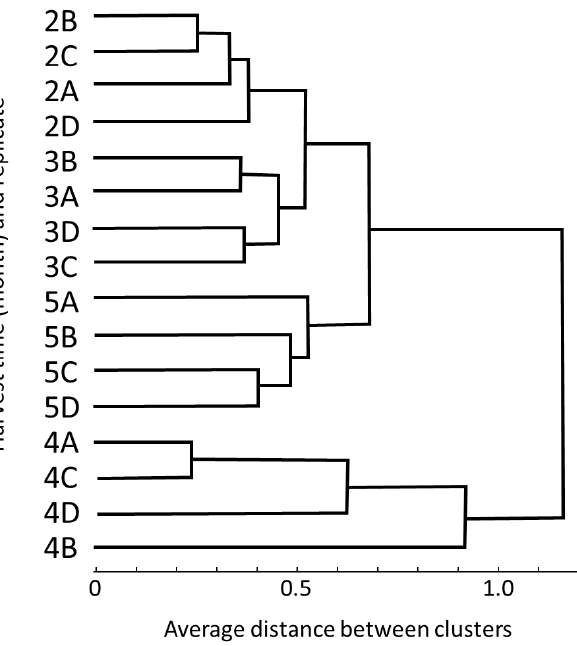
Figure 2. Cluster analysis of aroma quality of “Valencia” orange juice harvested from February to May 2012 based on 94 volatile compounds. “2”–“5” represent months (2 = February, 3 = March, 4 = April and 5 = May) and A–D represent replicates.